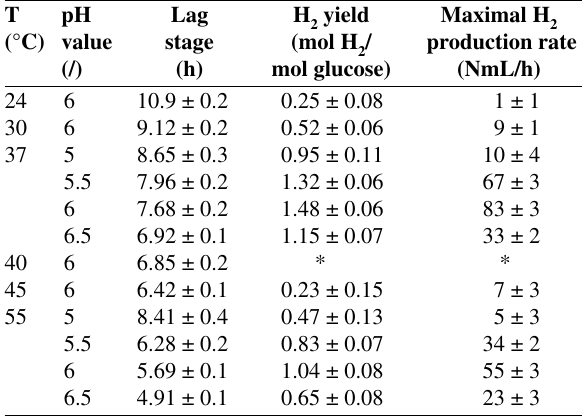
Table 4. Influence of temperature on hydrogen production under controlled pH